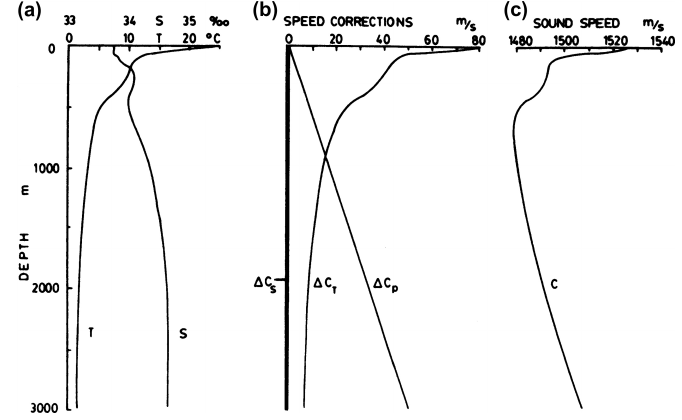
Figure 2. Temperature, salinity data and their impact on the sound speed profile.